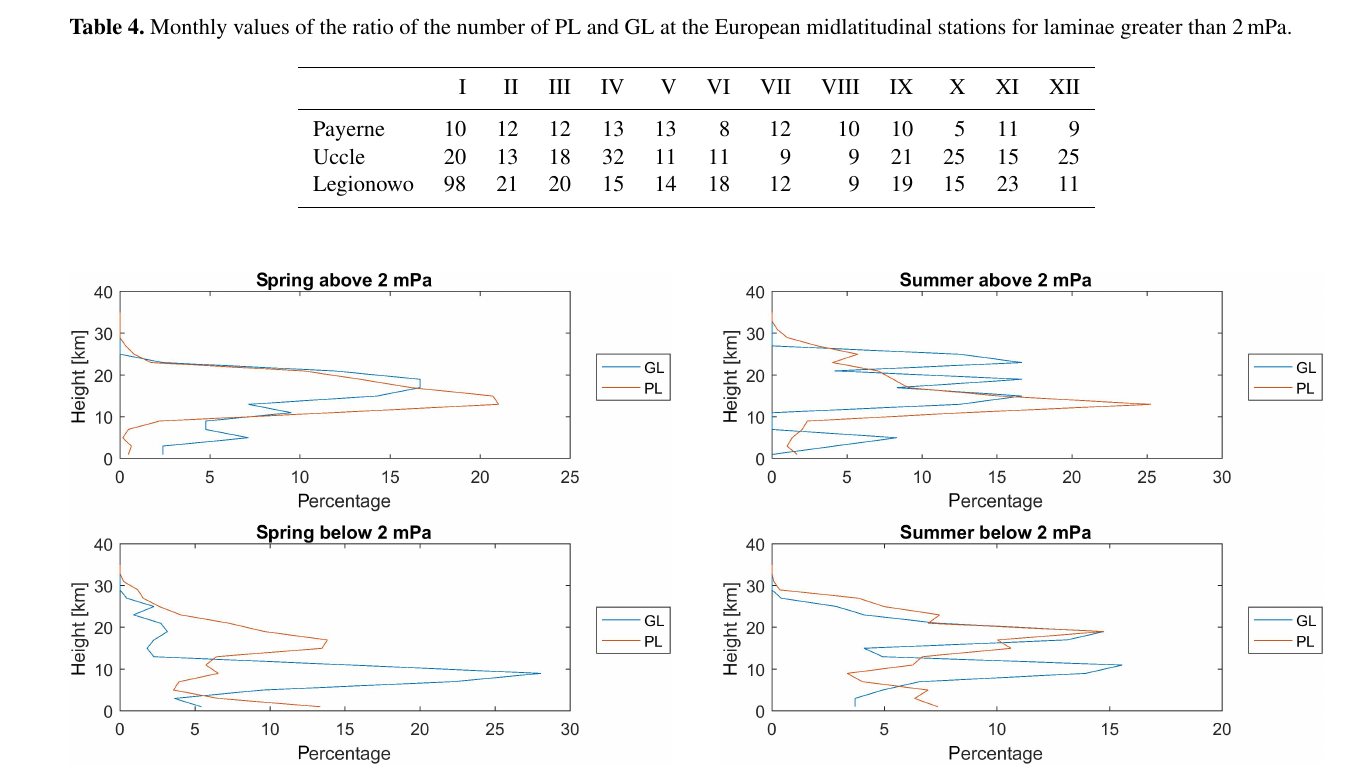
Figure 8. The vertical dependence of the occurrence of the laminae induced by the gravity waves and the ones induced by planetary waves at Payerne in the period 1995–2016 in winter in terms of percentage of all GL and all PL.